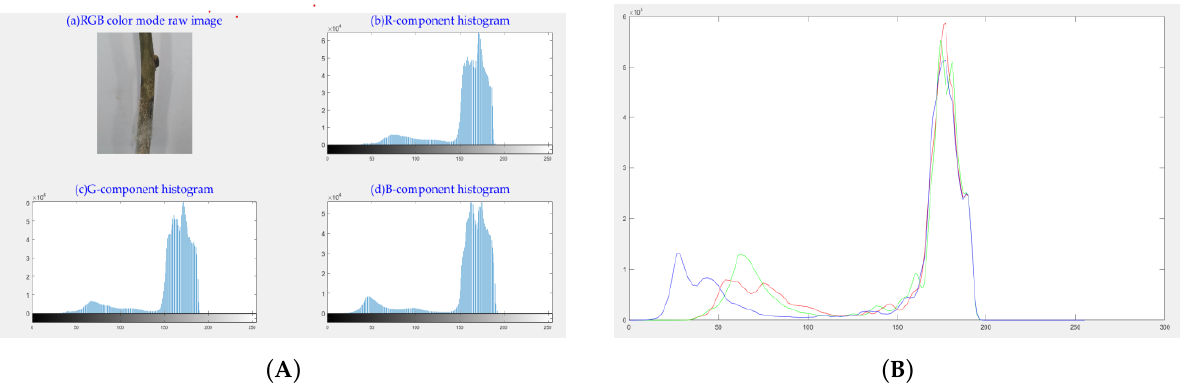
Figure 7. Histograms of each R, G and B component: ( A ) histograms of the grayscale of each RGB component; ( B ) RGB three-channel grayscale histogram.